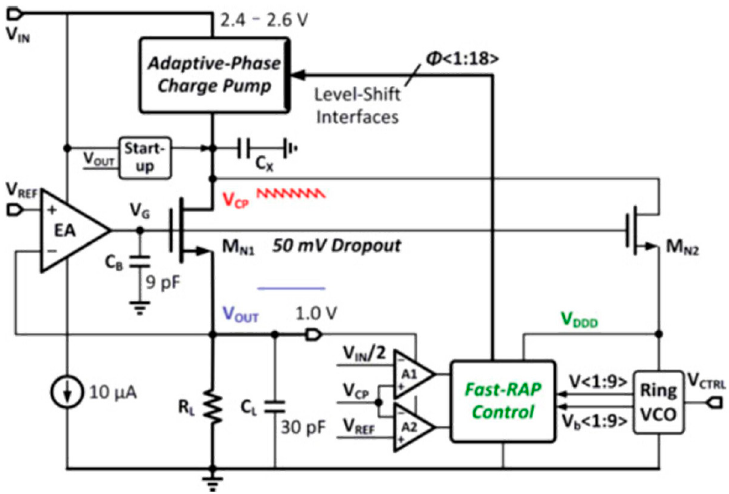
Figure 14. Block diagram of the fully integrated regulated switched capacitor dc–dc converter with fast-RAP control [25].